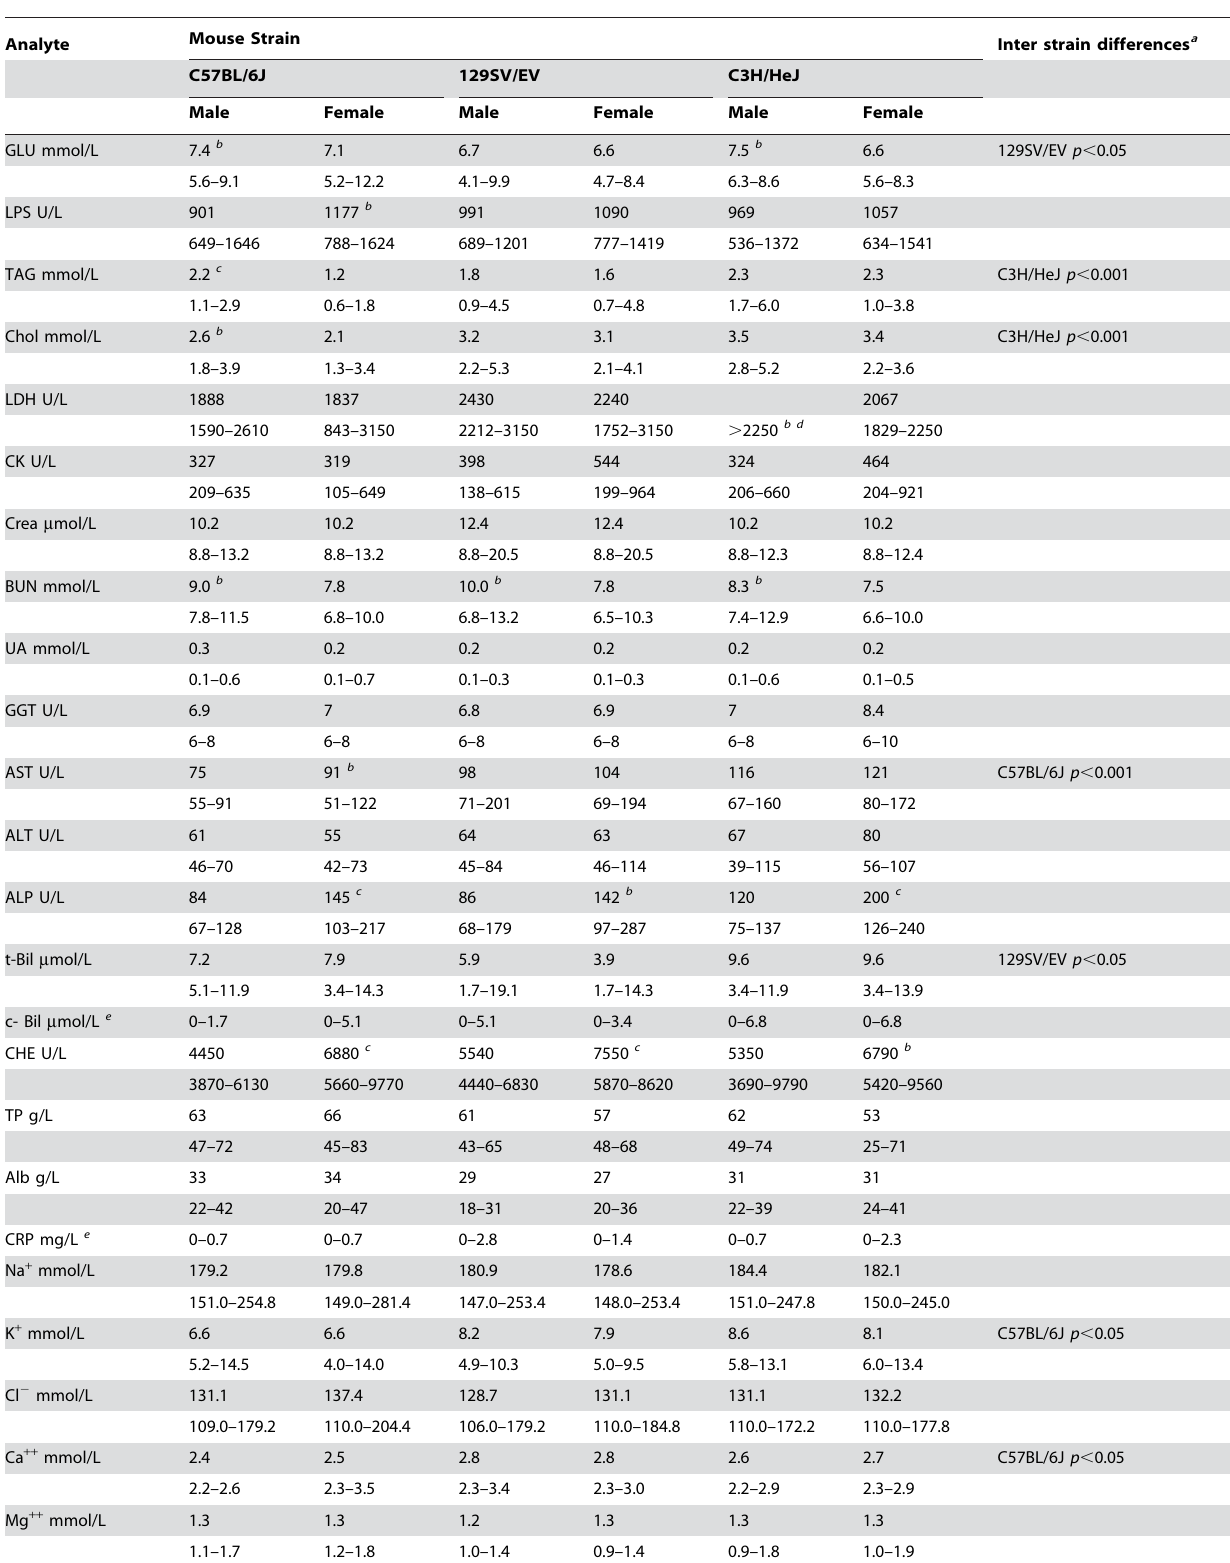
Table 1. Serum biochemical analytes (median and 2.5 th –97.5 th percentiles interval) measured in aged 4–8 months C57BL/6J, 129SV/EV and C3H/HeJ mouse strains